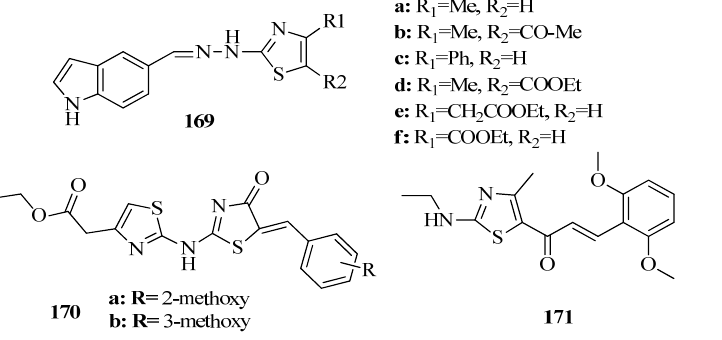
Figure 66. Structures of new 2-(2-((1H-indol-5yl)methylene)-hydrazinyl)–thiazoles ( 169a – f a; b; c; d; e; f; a; b; c; d; e; f; a; b; c; d; e; ), structures of compounds 170a , 170b , and 171.